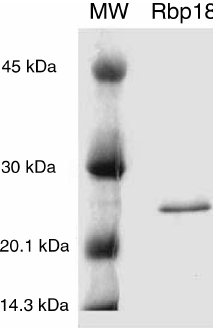
Figure 3. Distance tree showing the phylogenetic distribution of Rbp18 proteins. The scale bar gives the number of amino acid substi- tutions per site.